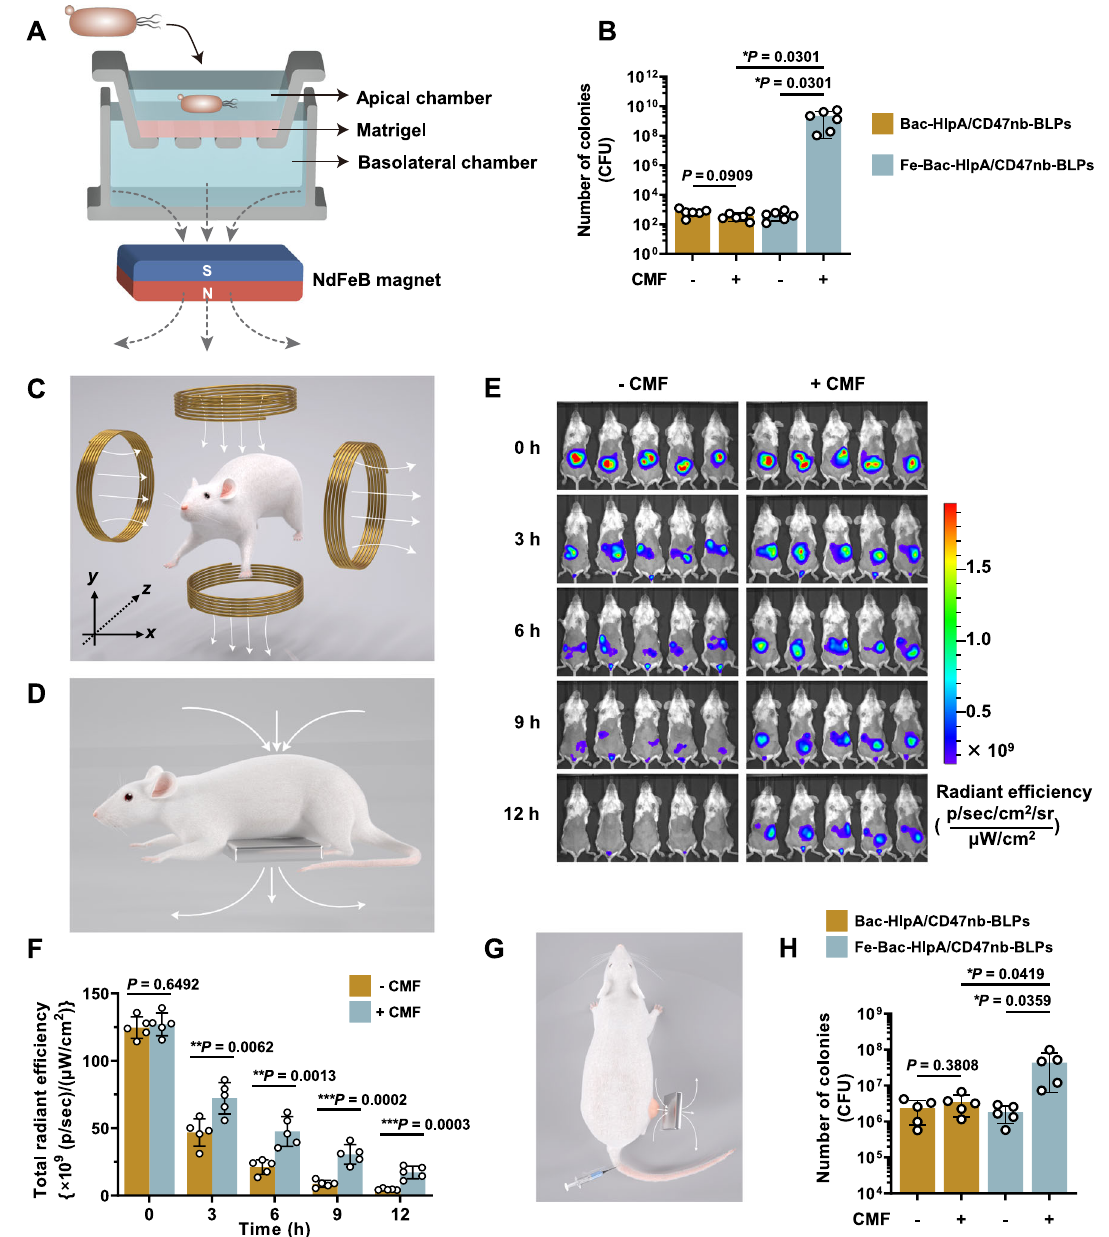
Fig. 9 | The constant magnetic fi eld (CMF)-controlled motion of AMF-Bac for enhanced tumor targeting. A Illustration of transwell assays for analyzing the CMF-controlled motion of AMF-Bac in vitro. A layer of Matrigel was spread on the bottom of the apical chamber. Bac-HlpA/CD47nb-BLPs or Fe-Bac-HlpA/CD47nb- BLPsdispersedinRPMI-1640mediumatdensityof1×10 8 CFUmL − 1 wasaddedinto the apical chamber, which was immersed in RPMI-1640 medium of the basolateral chamber.ANdFeBmagnetwasplacedbelowthebasolateralchamberforproviding CMF. After incubating at 37°C for 12h, the medium of basolateral chamber was sampledformeasuringthenumberofbacteria. B Thenumberoflivebacteriainthe medium of basolateral chamber ( n =6 chambers) in panel A, measured by spread plate method. C Illustration of controlling AMF-Bac motion in vivo using two- dimension CMF. D – F Prolonged retention time of AMF-Bac in intestinal tracts by controlling AMF-Bac motion using one-dimension CMF. BALB/c mice were colon- speci fi cally administrated with Cy5.5-labeled Fe-Bac-HlpA/CD47nb-BLPs. A NdFeB